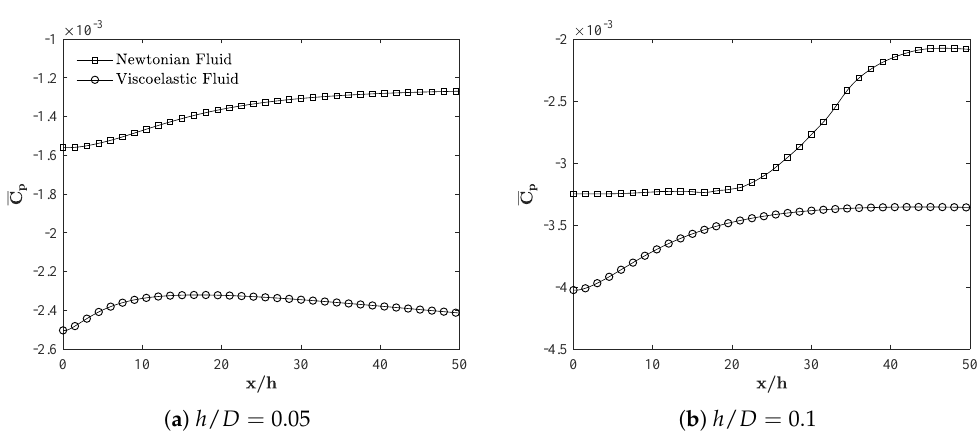
Figure 8. Mean pressure coefficient profile ( C p ) on the pipe wall behind both bar heights at x / h = 0–50.